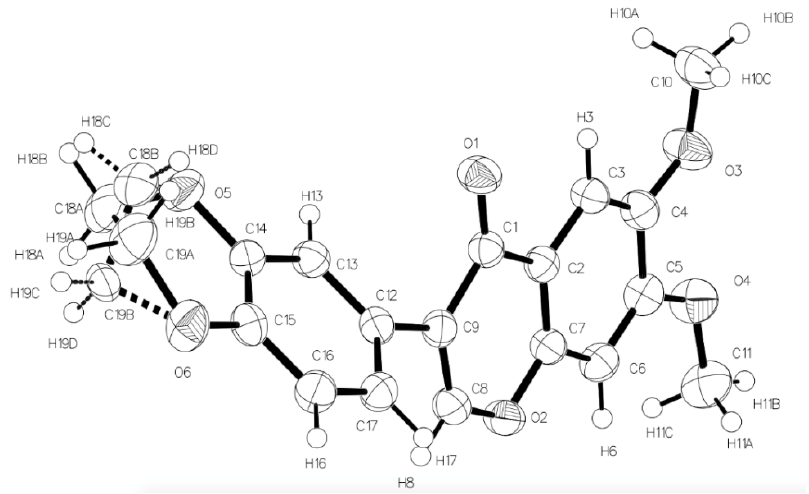
Figure 2. View of the molecular structure of the independent molecule 5I with the atom label including all hydrogens. It shows a disordered structure in the 1, 4-dioxane rings. Displacement ellipsoids are drawn at the 30% probability level.